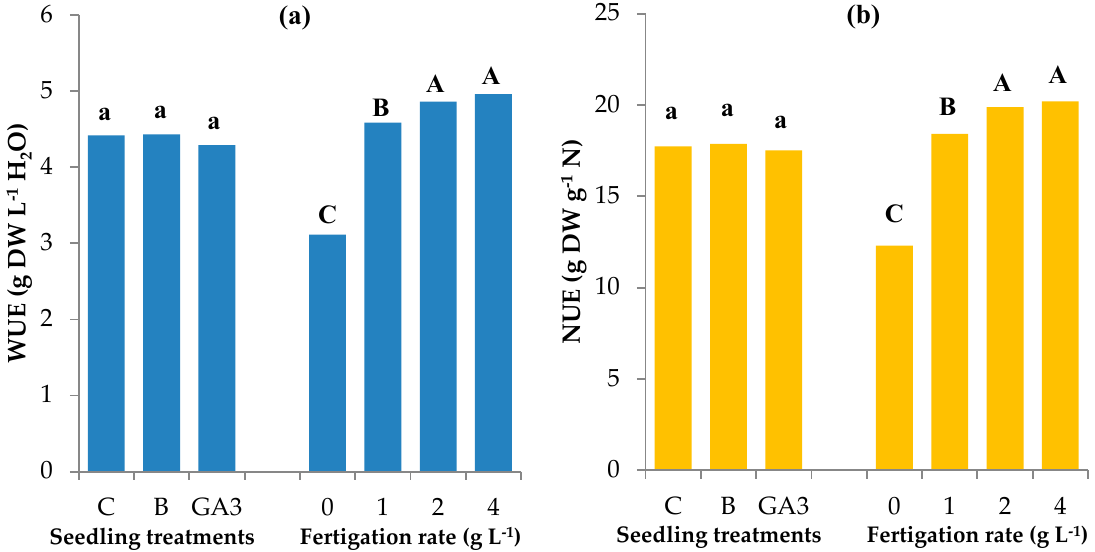
Figure 12. Effect of the seedling treatments (C, untreated control, B, bacterial biostimulant, GA3, gibberellic acid spray 10 − 5 M) and the nursery fertigation rates (g L − 1 of NPK 20 ‐ 20 ‐ 20) on ( a ) the water use efficiency (WUE) and ( b ) the nitrogen use efficiency (NUE) of Solanum lycopersicum ‘Marmande’ plants grown in soilless cultivation (bars with different letters are significantly different at p < 0.05 according to the LSD test).